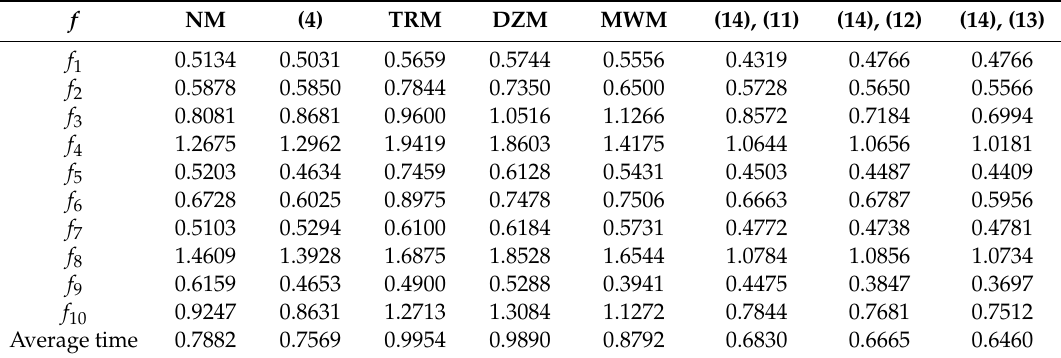
Table 11. Mean CPU time of iterative method for solving di ff erent functions.